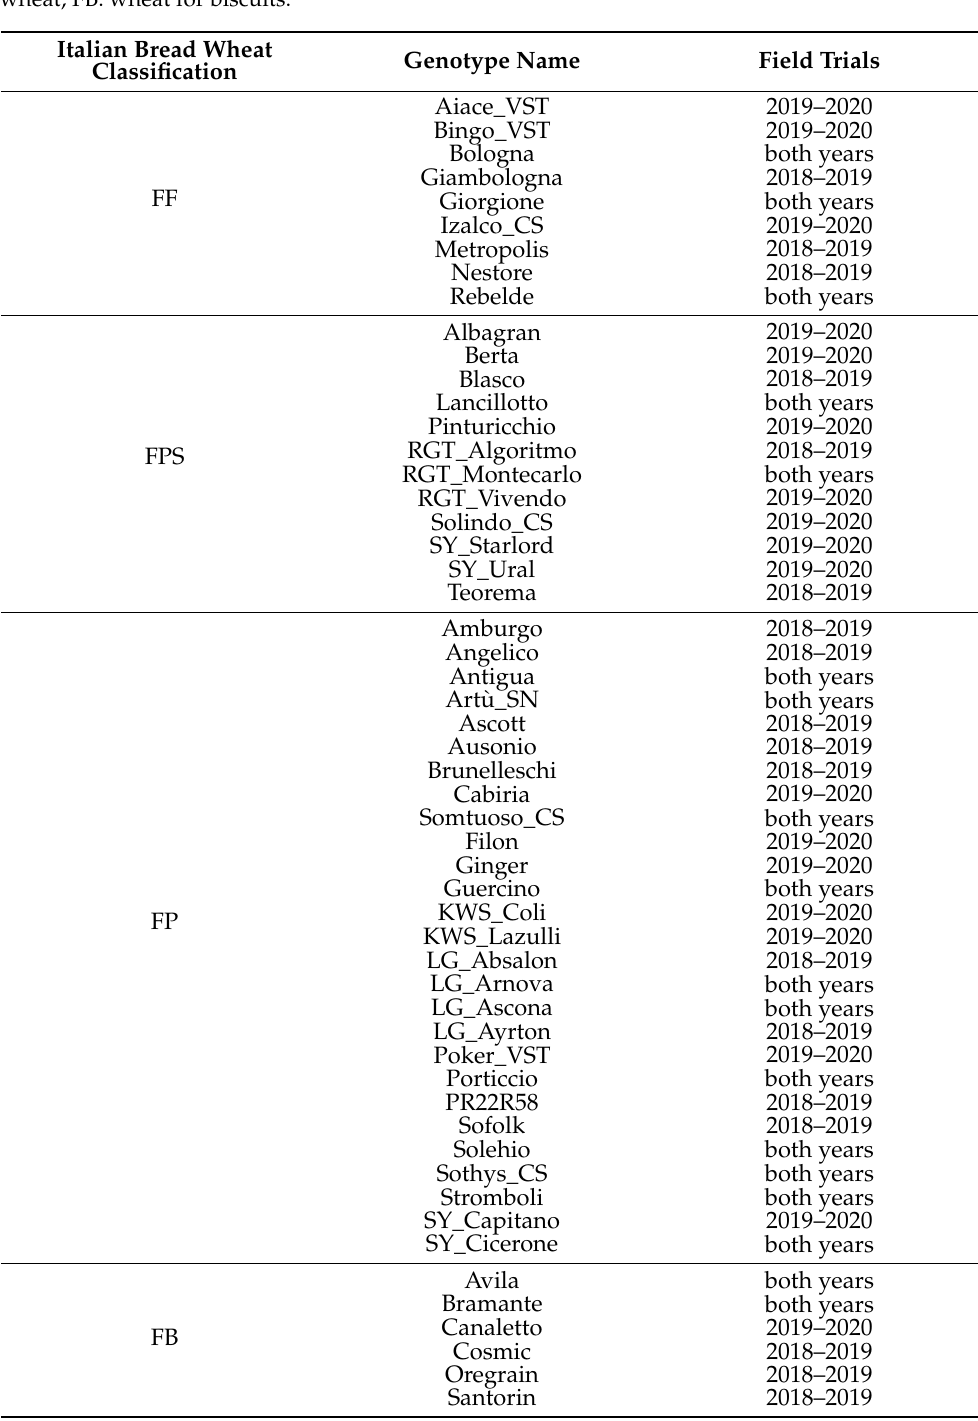
Table 1. List of the 54 analysed varieties used in the six field trails. The varieties are grouped according to the Italian bread wheat classification, which is based on specific rheologic and analytical parameters [31]. FF: improver wheat; FPS: superior bread making wheat; FP: ordinary bread making wheat; FB: wheat for